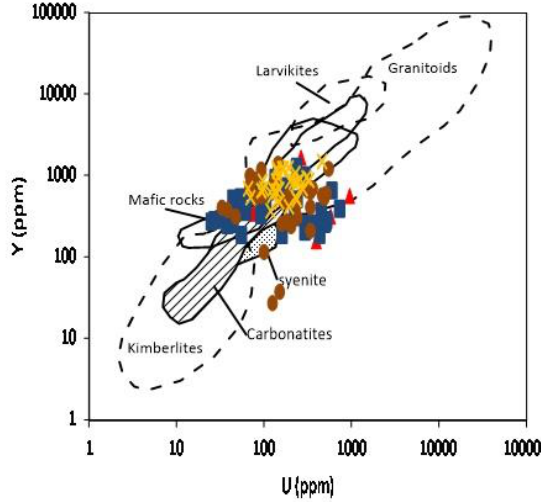
Figure 9. Y versus U plot for southern Meiganga detrital zircons (the lithounit fields are from [4,71]). Red triangles represent zircon with Th/U < 0.2; blue squares represent zircon with Th/U ratios [0.2 to 0.5]; brown circles represent zircons with Th/U ratios [>0.5 to 1.0]; and stars represent zircons with Th/U > 1.0.